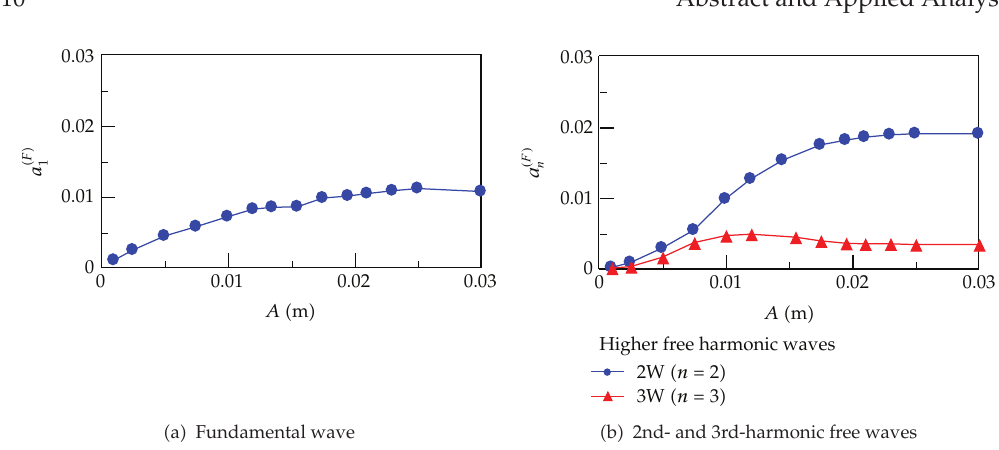
Figure 9: First-, second-, and third-harmonic free wave amplitudes at the lee side of submerged bar for h (cid:9) 0 . 4m.